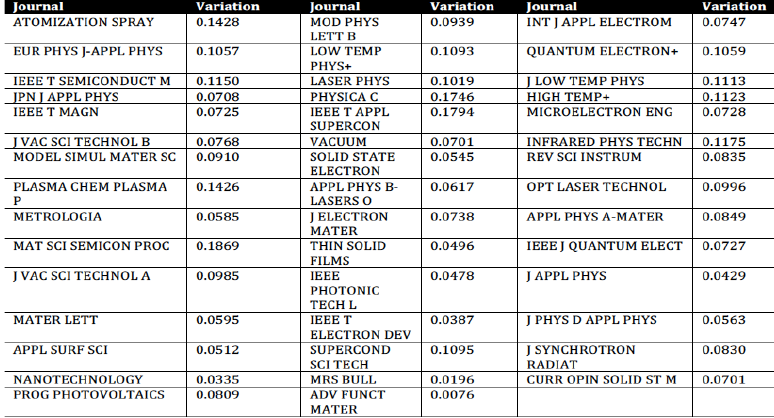
Figure 3. Mean variations of the journals in the list of applied physics.